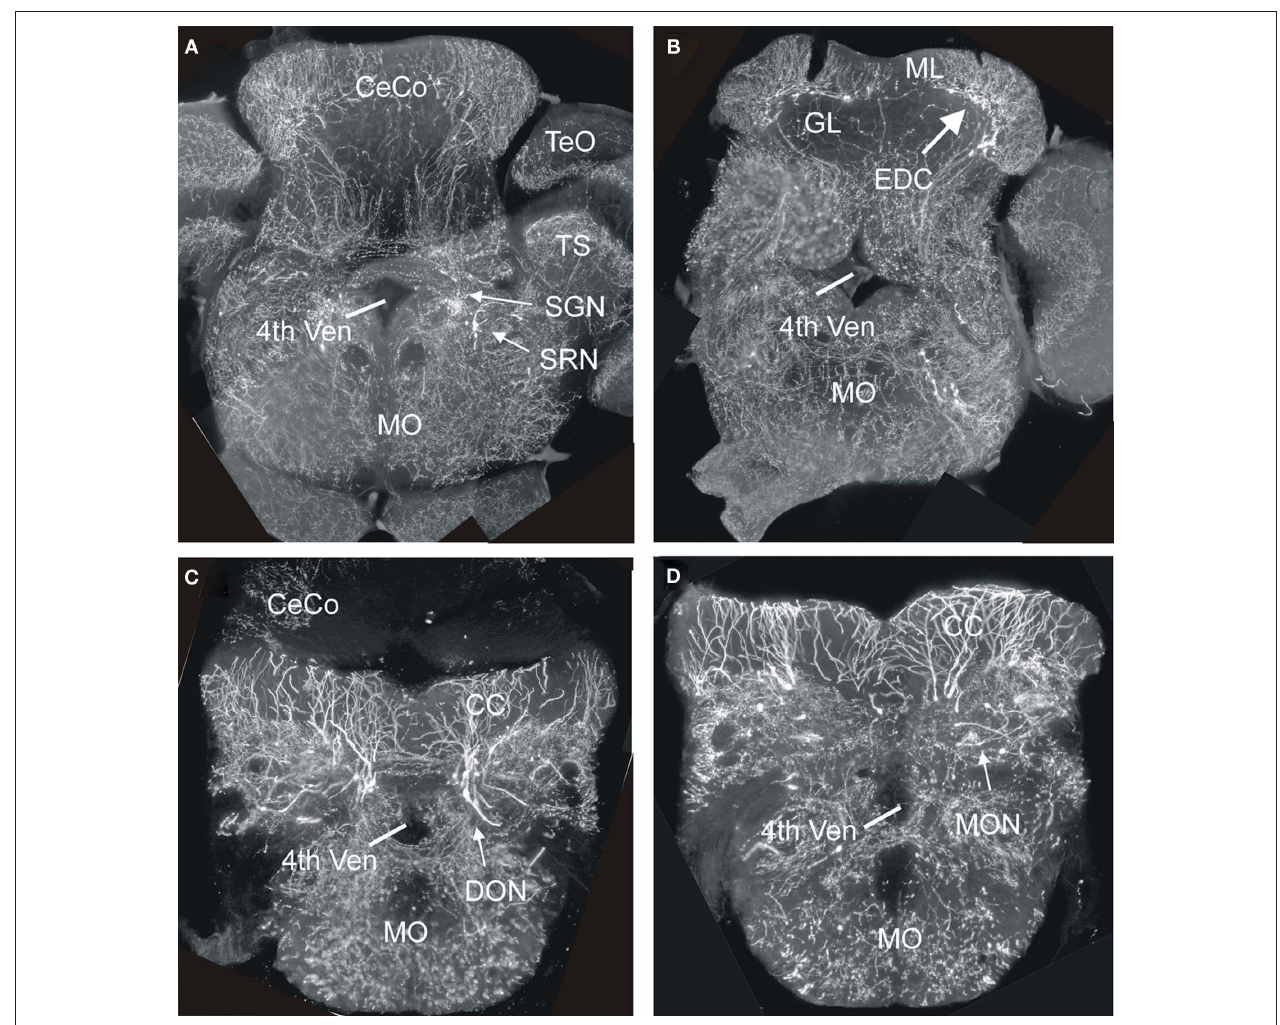
been described in detail in Distel et al., 2009, 2010). 4th ven, fourth ventricle; CC, crista cerebellaris; CeCo, cerebellar corpus; DON, descending octaval nucleus; EDC, eurydendroid cells; GL, granular layer; ML, molecular layer; MO, medulla oblongata; MON, medial octavolateralis nucleus; SGN, secondary gustatory nucleus; SRN, superior reticular nucleus; TS, torus